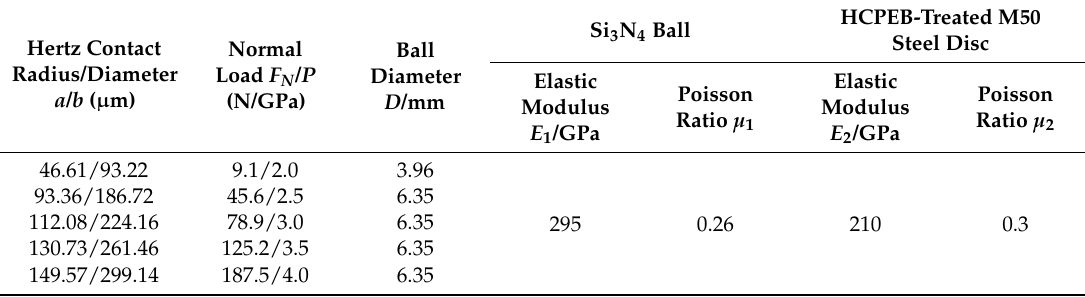
Table 2. Calculation parameters of theoretical Hertz contact radius of an HCPEB-treated M50 steel disc against an Si 3 N 4